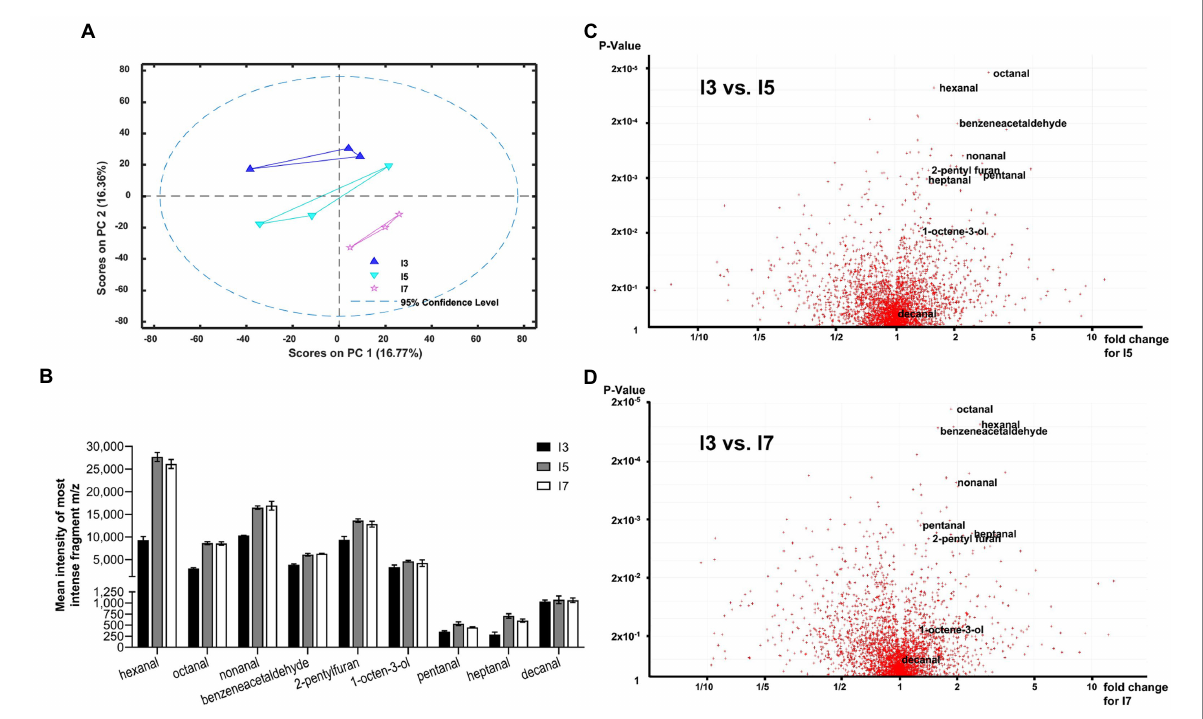
FIGURE 3 Volatile analysis of pearl millet I3, I5 and I7 lines using Solid Phase Micro-Extraction Electron Impact Ionization Gas Chromatography Mass Spectrometry (SPME-EI-GC-MS). (A) First and second principal components for processed auto-scaled datasets for the I3, I5 and I7 lines (blue triangles, aquamarine inverted triangles and pink stars, respectively). A 95% confidence range is indicated by a dashed line. (B) Most abundant fragment m/z total peak intensity bar charts for lowest value of p aldehydes (C 5 –C 10 ) for the I3, I5 and I7 lines. (C , D) Volcano plots generated from 2 groups sample comparison tests for I3 vs. I5 (C) and I3 vs. I7 (D) . Most statistically significant aldehydes as measured by value of p are shown labeled. See Supplemental Table S5 for the detailed statistical